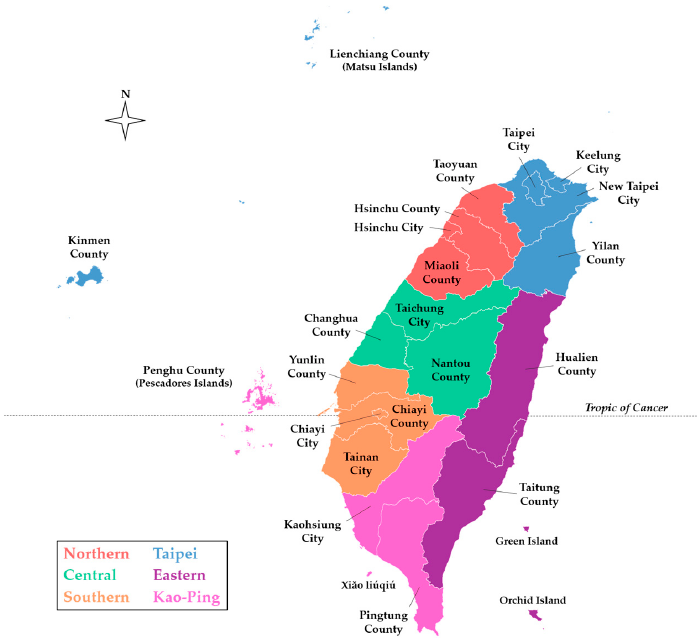
Figure 2. County-level map of Taiwan indicating the six regions of the Taiwan CDC NNDSS [7].